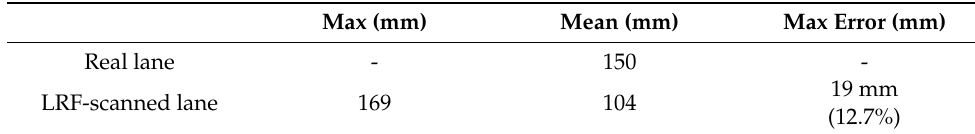
Table 5. Lane width error of feature point extraction.